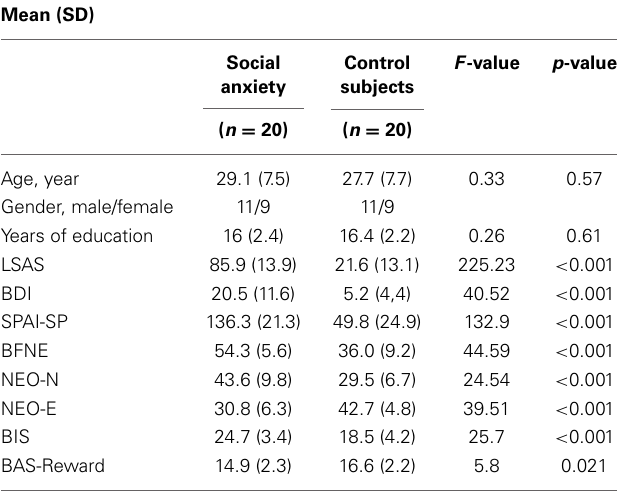
Table 1 | Participant